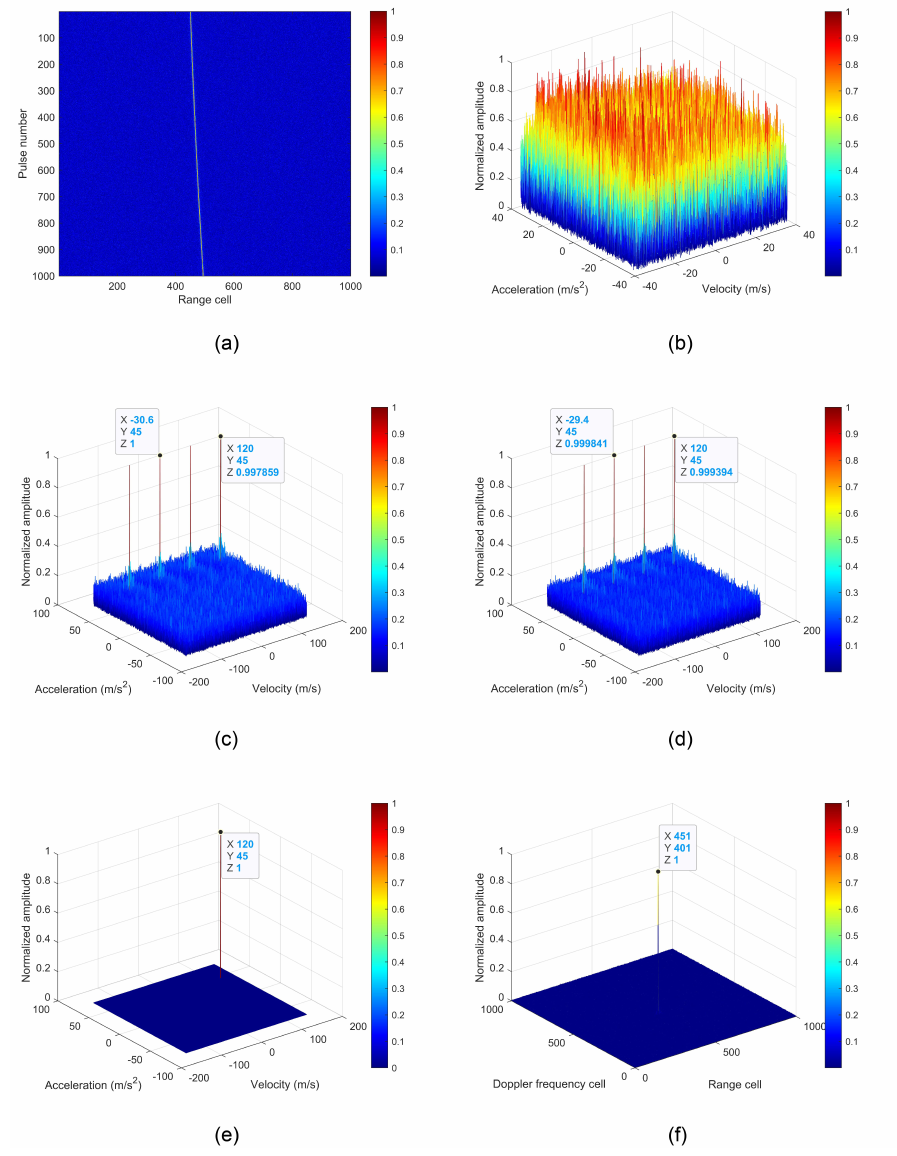
Figure 7. Coherent integration for a single target at SNR = 20 dB. ( a ) The result of PC. ( b ) The result of MDCFT at f = − 4 MHz. ( c ) The result of SZDCFT at f = − 4 MHz. ( d ) The result of SZDCFT at f = 4 MHz. ( e ) The result of PSZDCFT. ( f ) The result of coherent